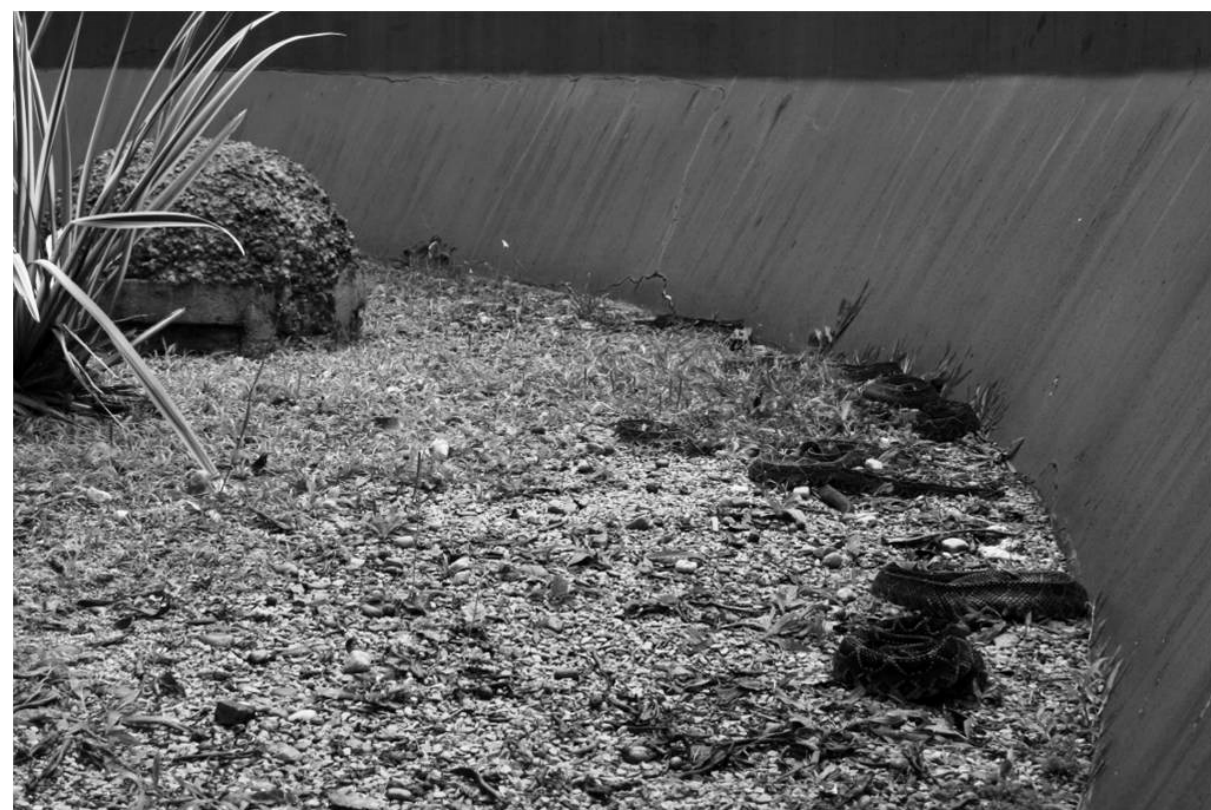
Figure 5. Crotalus basking in the sun during the